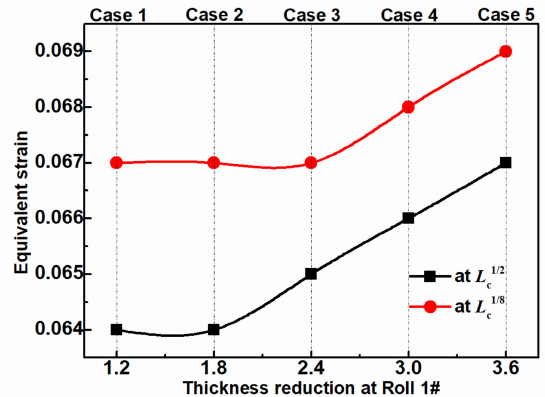
Figure 19. Equivalent strain at the slab center of 1/8 width ( L c1/8 ) and 1/2 width ( L c1/2 ) after 6% HR deformation in Case 1 to